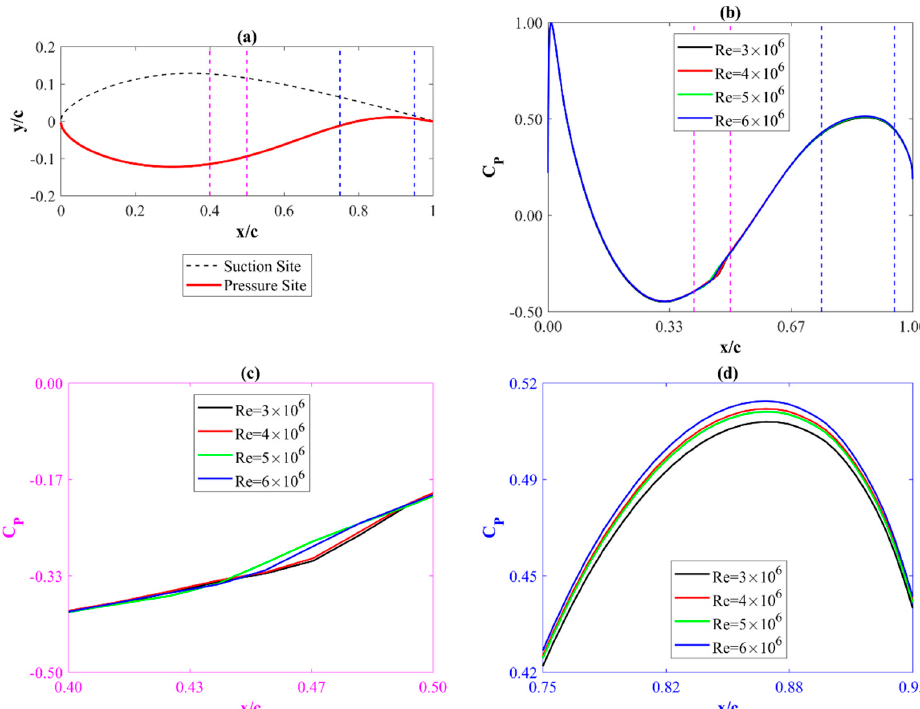
Figure 9. Effect of the Reynolds number on static pressure coefficient characteristics: ( a ) airfoil shape; ( b ) distribution of the static pressure coefficients on the pressure side of the airfoil; ( c , d ) details of the static pressure distributions on the pressure side of the airfoil—the details are marked in these figures with the appropriate colors.